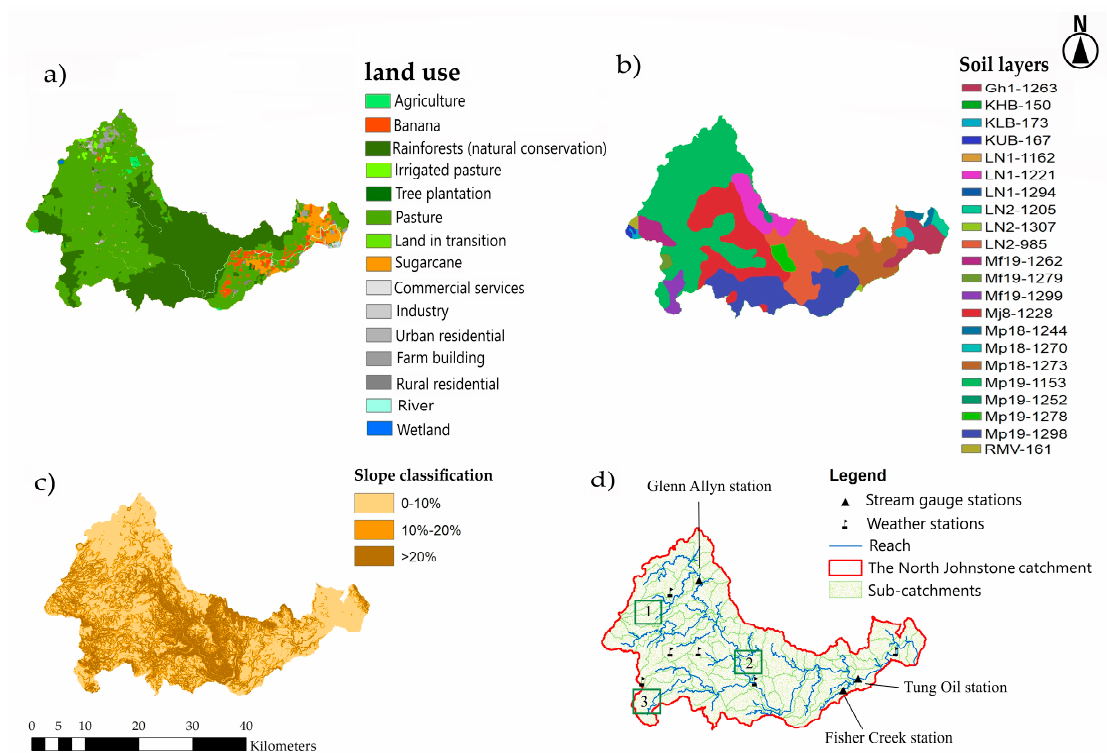
Figure 2. ( a ) land use map, ( b ) soil layer map, ( c ) slope classification and ( d ) catchment details including the location of weather stations, monitoring stations, catchment outlet, river and streams. Legends of the soil layers represent their soil feature names and associated feature ID numbers in the ASRIS database in which the Gh1 is red smooth-ped earths moderately undulating lands; KHB is Krasnozems of the undulating and rolling hills on; KLB is Krasnozems of the basalt lava plains; KUB is Krasnozems of the undulating basalt lava plains; LN1 is pale loams with a smooth-ped B horizon; LN2 is pale loams with a smooth-ped B horizon, high hills; Mf19 is yellow smooth-ped earths, strongly undulating; Mj8 is red smooth-ped earths, hilly high plateau; Mp18 is red smooth-ped earths, moderately undulating lands; Mp19 is red smooth-ped earths, low hilly to hilly basalt; RMV is red podzolics of the steep hills and mountains.